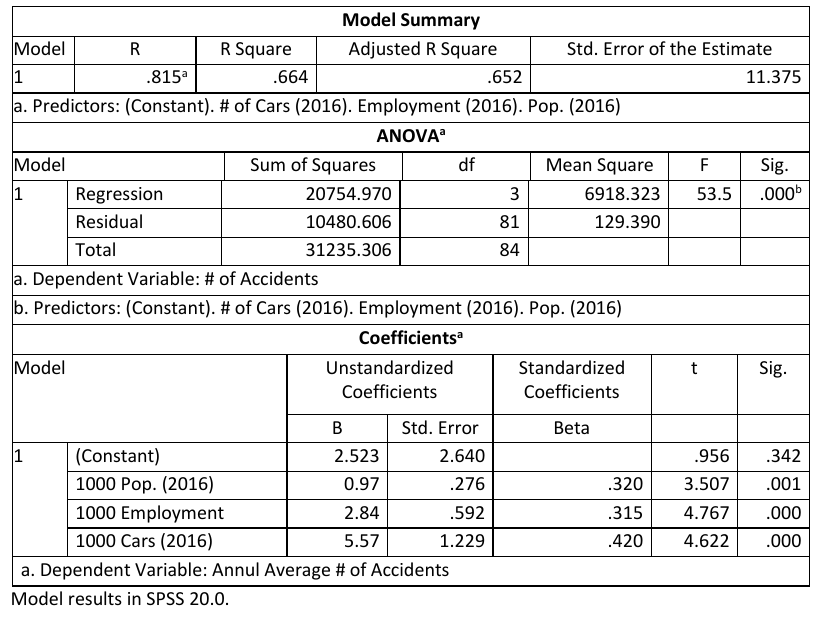
Table 1 Model 1 Regression Results (Model summary, ANOVA and Coefficients)